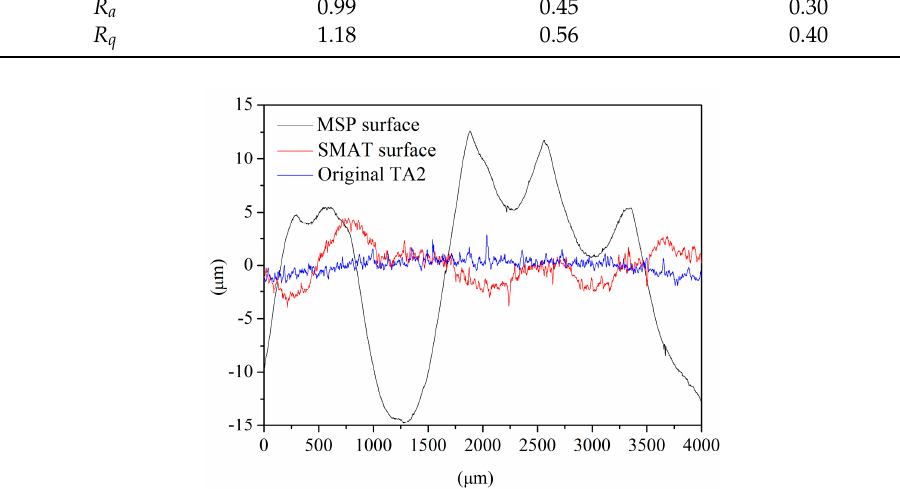
Figure 7. Surface profiles of three kinds of specimens.